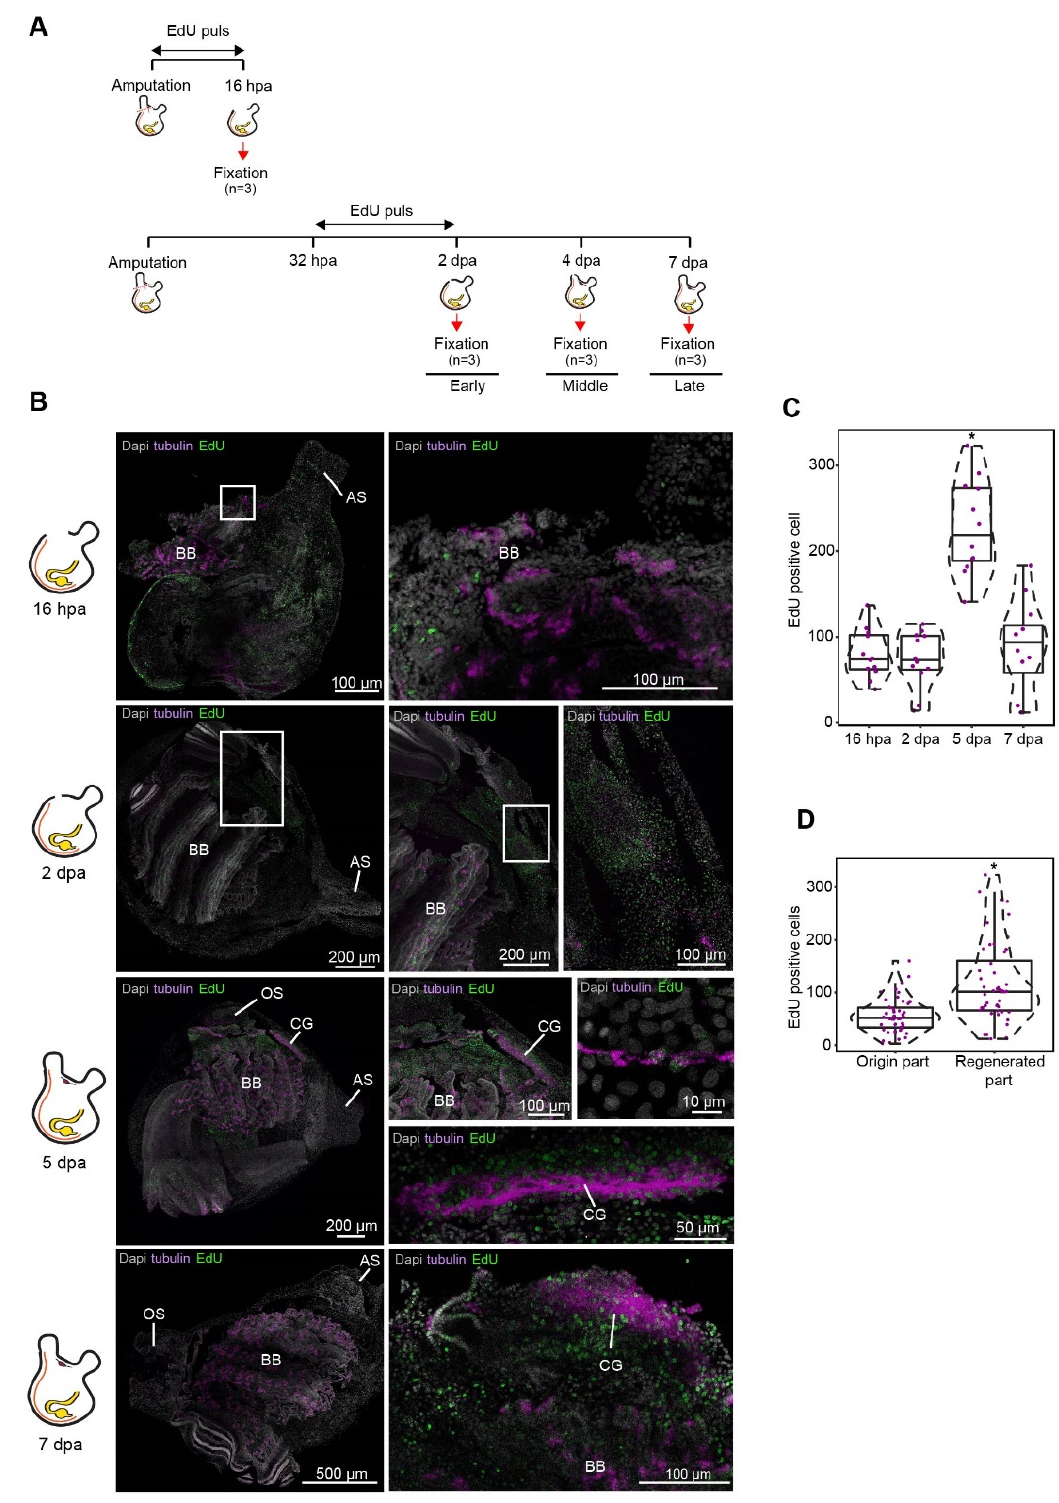
Figure 3. Cell proliferation increase during CNS regeneration. ( A ) Experimental timeline and illustration of experimental paradigm. ( B ) Whole mount EdU staining and tubulin expression during CNS regeneration. All panels are anterior to the top, right view. Whole mount staining of CNS regeneration at 16 h, 2, 5, and 7 dpa showing newly divided EdU positive cells in the regenerated tissue and in regenerating nerve fibers expressing tubulin. Enlargements of the square area appear in the following image in the panel. At 16 hpa the wound is open and the neural complex is absent. Cilia in the exposed branchial basket (BB) are positive for tubulin. At 2 dpa the wound is closed but the neural complex is still absent. EdU positive cells can be seen in the regenerated body wall. At 5 and 7 dpa we see the regenerated cerebral ganglion (CG) composed of tubulin and EdU positive cells. Anterior siphon (AS) and oral siphon (OS). (C and D) Quantification of EdU-positive cells in